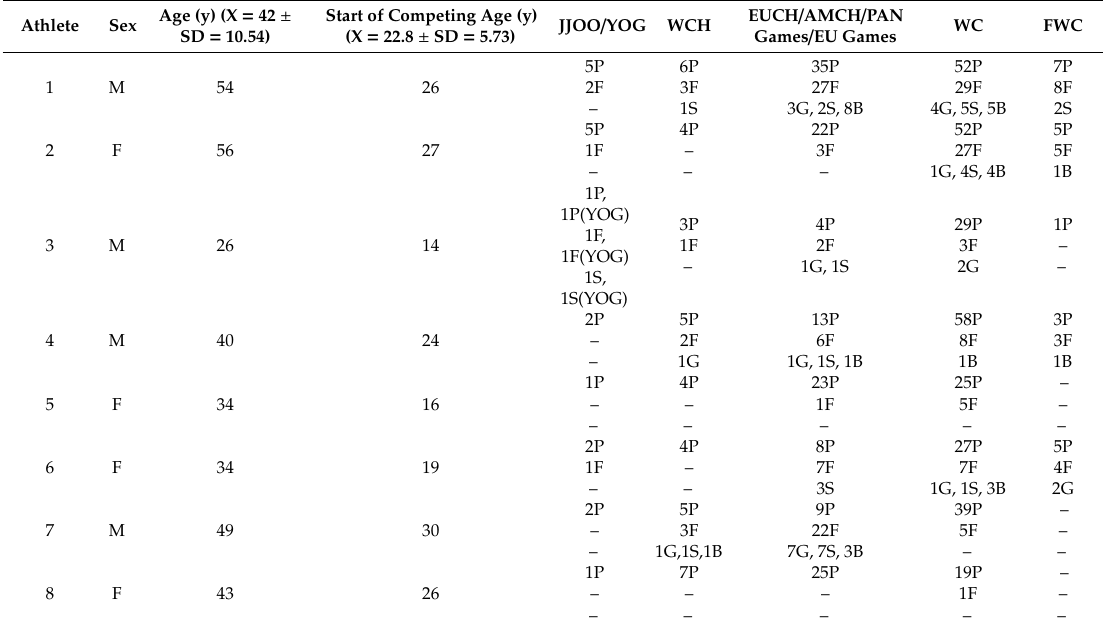
Table 1. Participants profiles, number of participations in first level international competitions, times finalist and